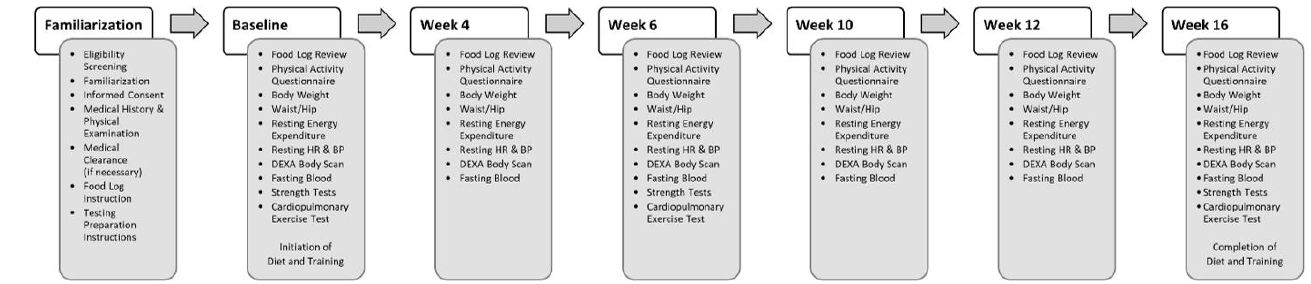
Figure 1. Overview of testing sessions and assessments performed. DEXA is dual-energy X-ray absorptiometry, HR is heart rated, BP is blood pressure.